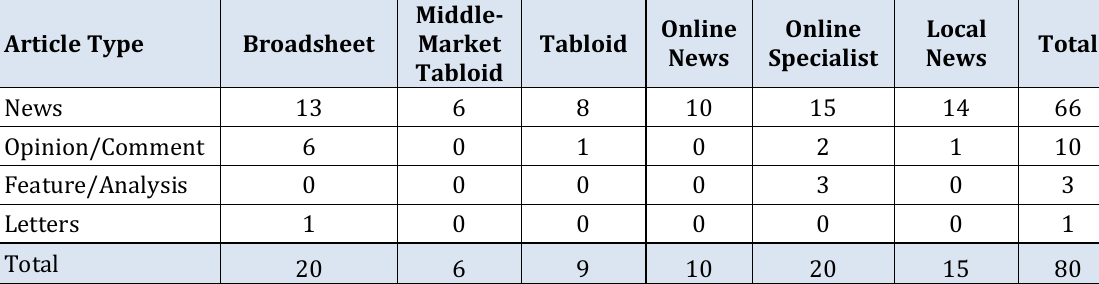
Table 2: Article Type by Source